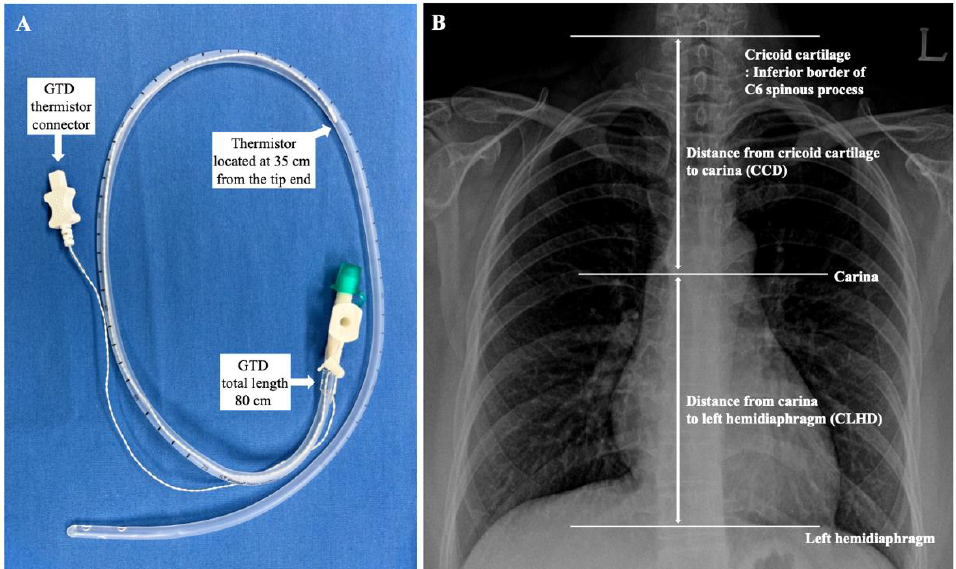
Figure 1. ( A ) Gastric decompression tube (GDT). The total length of the tube was 80 cm, and the thermistor was located at 35 cm from the end of the GDT tip. ( B ) Assessment of anatomical landmarks on chest